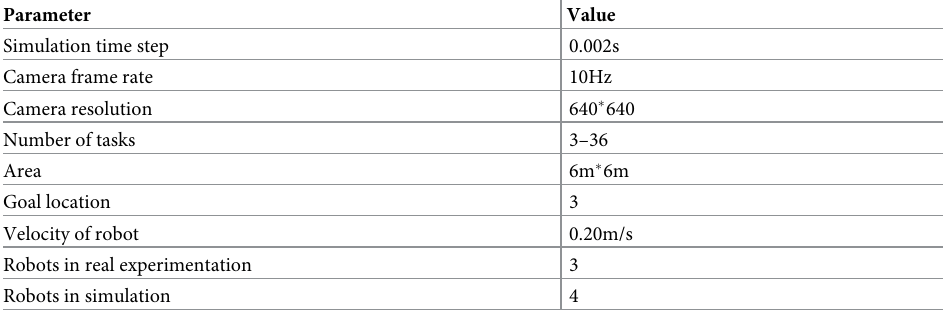
Table 2. Parameters used for